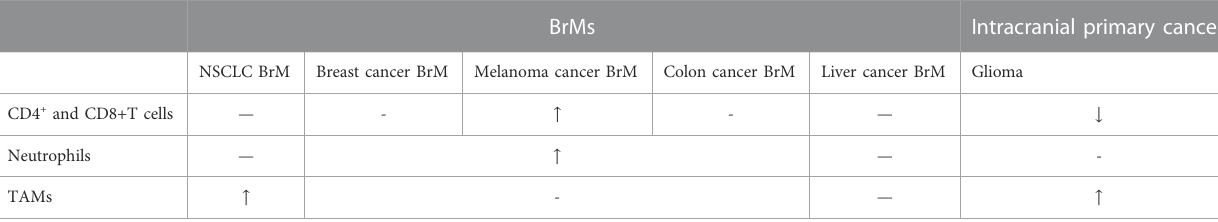
TABLE 2 Comparison between BrMs and glioma. NSCLC represents non-small cell lung cancer.